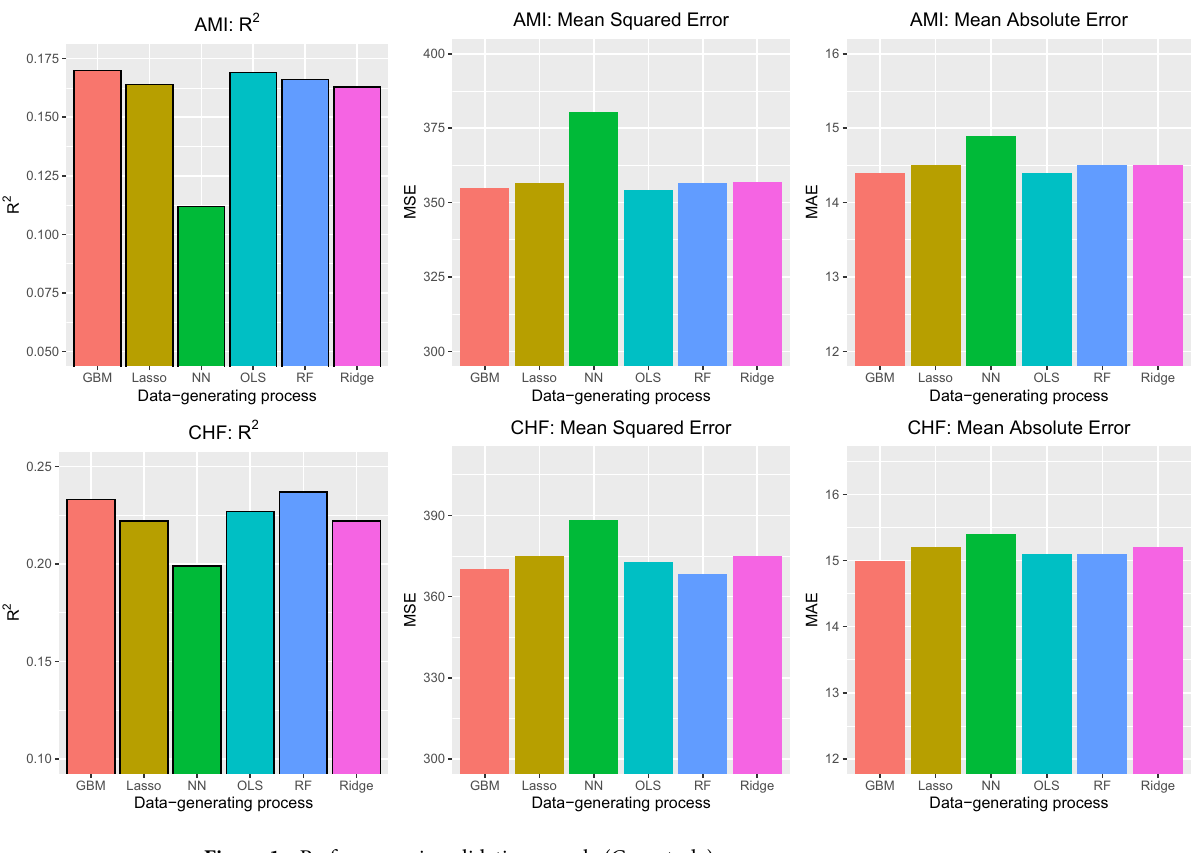
Figure 1. Performance in validation sample (Case